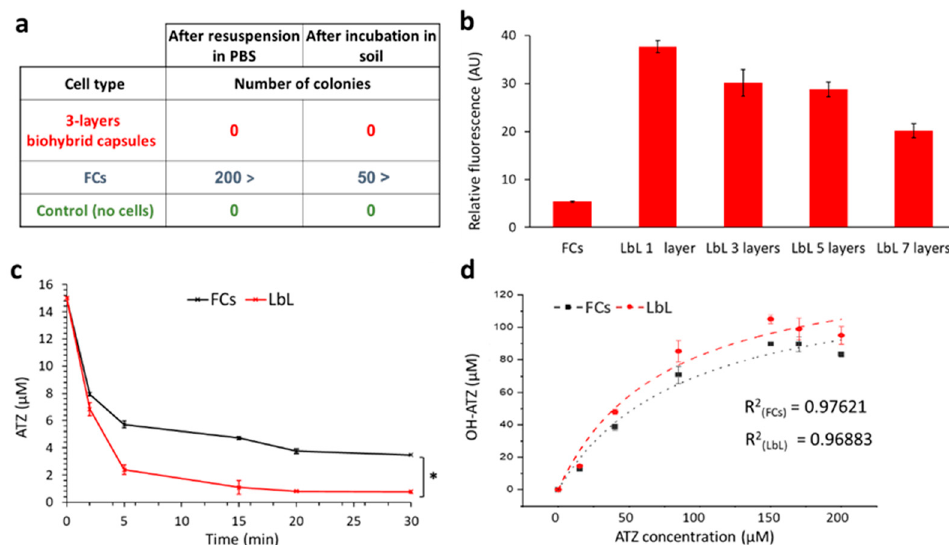
Figure 4. ( a ) Colony formation assay post resuspension in PBS and post incubation in soil ( b ) Relative fluorescence intensity in arbitrary units ( c ) Concentration of ATZ in the solution over time (initial concentration of 15 µM) ( d ) OH-ATZ formation at different initial ATZ concentrations. * Indicates significant difference between the groups ( p < 0.05).